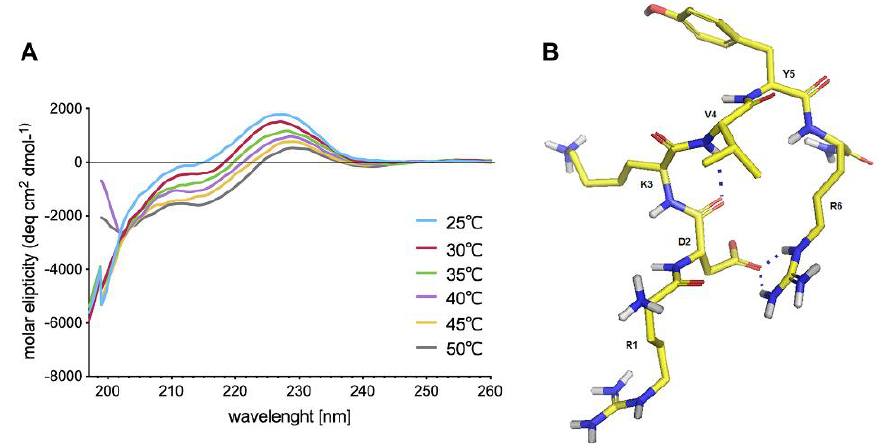
Figure 1. ( A ) CD spectra of Imunofan (IM) peptide in PBS at pH 7.4, over the temperature range